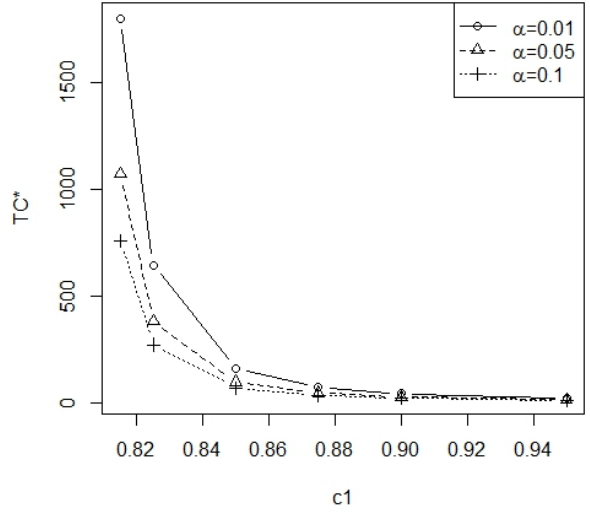
Figure 3. The minimum total cost curve for α = 0.01, 0.05, 0.1.